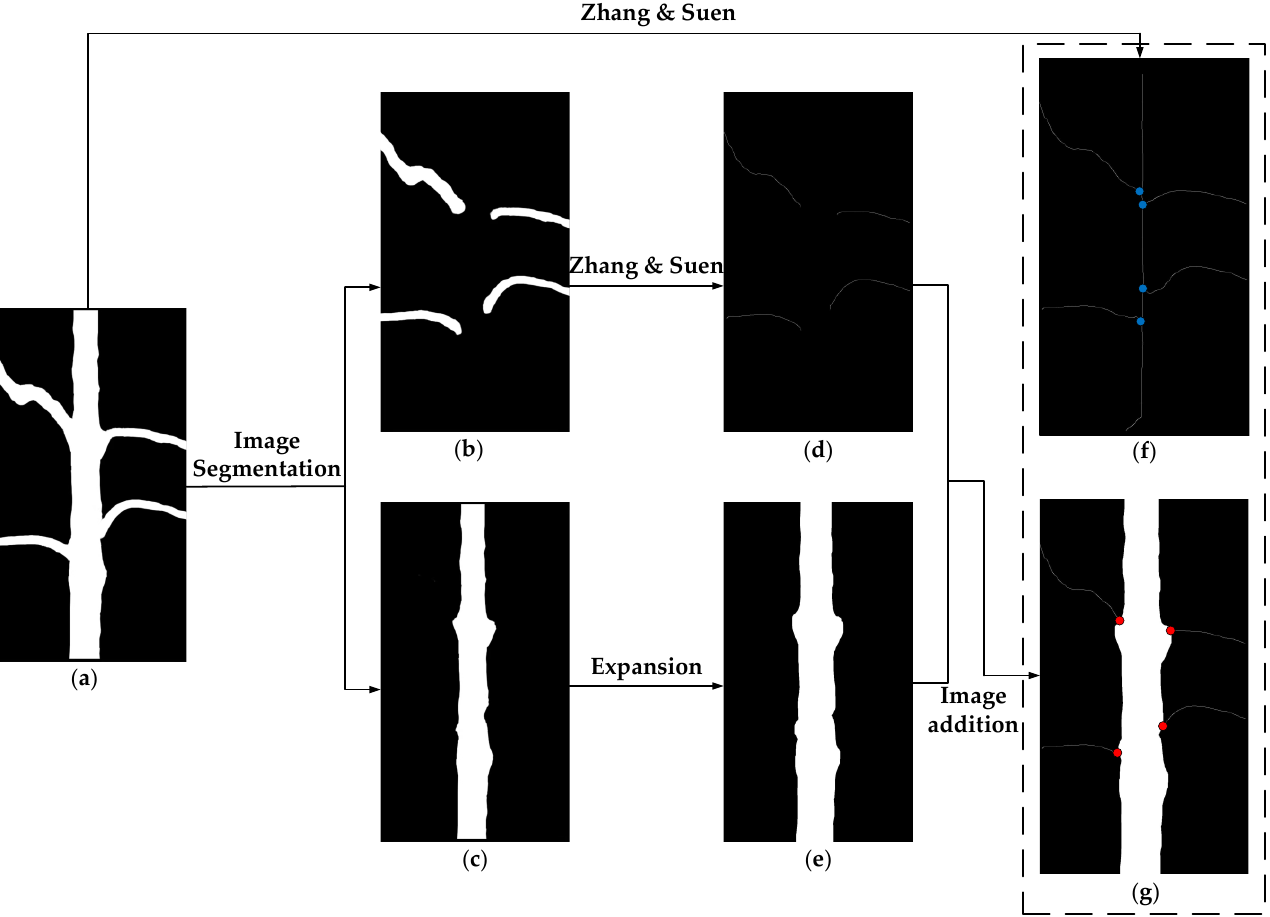
Figure 10. Process of skeletonization and junction point location: ( a ) binary image of the apple tree; ( b ) mask image of primary branch; ( c ) mask image of the trunk; ( d ) primary branch skeleton processed by Zhang & Suen; ( e ) expanded trunk mask image; ( f ) skeleton and junction points of apple tree directly processed by Zhang & Suen; ( g ) skeleton and junction points obtained by Cascade Mask R-CNN SW-T combined with Zhang & Suen.